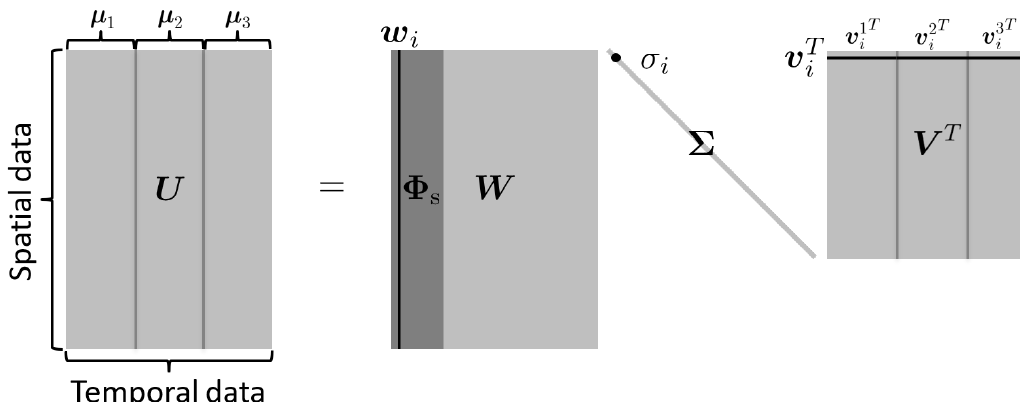
Figure 1. Illustration of spatial and temporal bases construction, using SVD with n µ = 3. The right singular vector, v i , describes three different temporal behaviors of a left singular basis vector w i , i.e., three different temporal behaviors of a spatial mode due to three different parameters that are denoted as µ v 2 , and v 3 i i